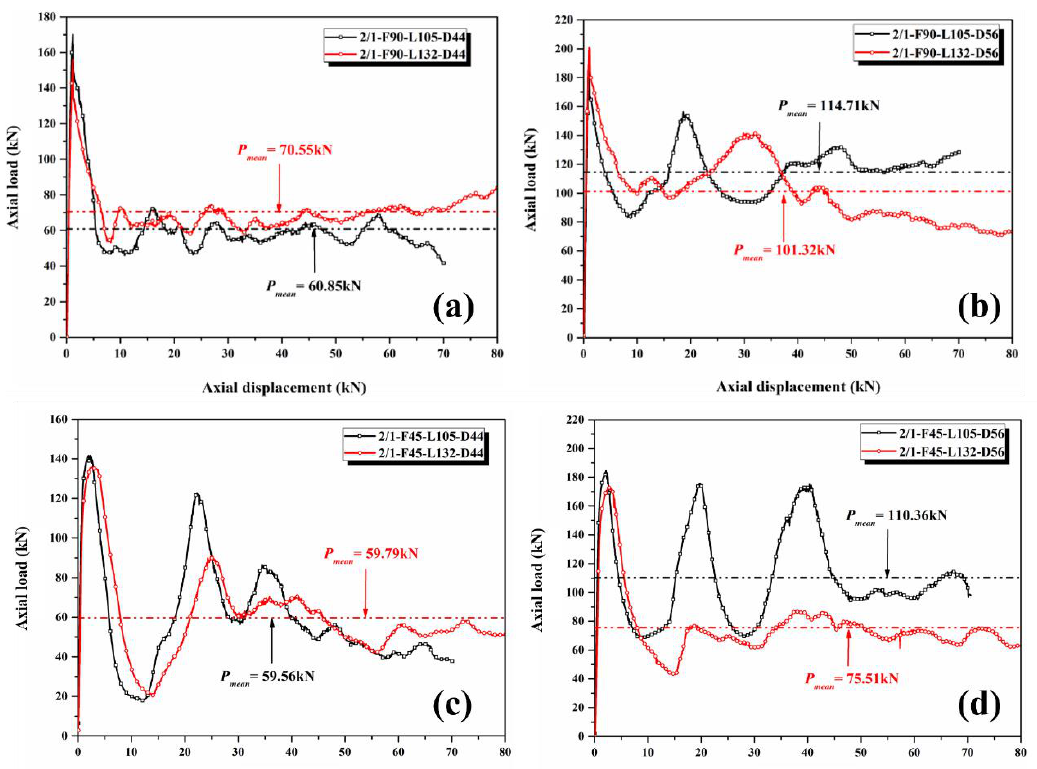
Figure 10. Load–displacement curve of 2/1 hybrid tubes: [0 ◦ /90 ◦ ] lay-up sequence with a nominal Figure 10. Load – displacement curve of 2/1 hybrid tubes: [0°/90°] lay-up sequence with a nominal outer diameter of ( a ) 44 mm and ( b ) 56 mm; [45 ◦ / − 45 ◦ ] lay-up sequence with a nominal outer outer diameter of ( a ) 44 mm and ( b ) 56 mm; [45°/ −4 5°] lay-up sequence with a nominal outer diam- diameter of ( c ) 44 mm and ( d ) 56 eter of ( c ) 44 mm and ( d ) 56 mm.